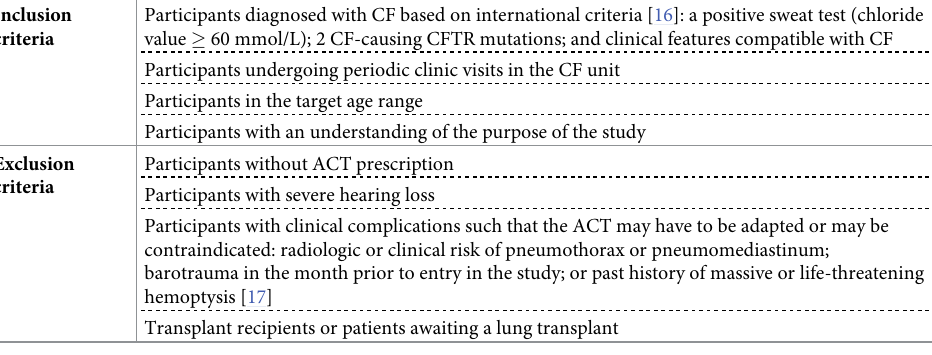
Table 1. Clinical trial inclusion and exclusion